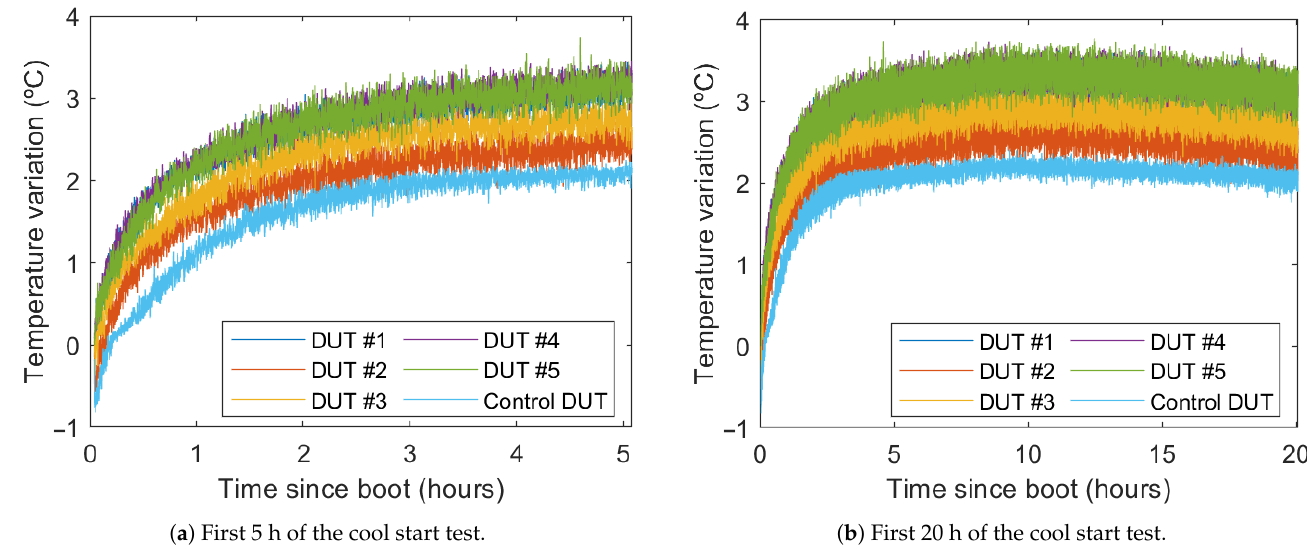
Figure 8. Temperature variation during the cool start test.